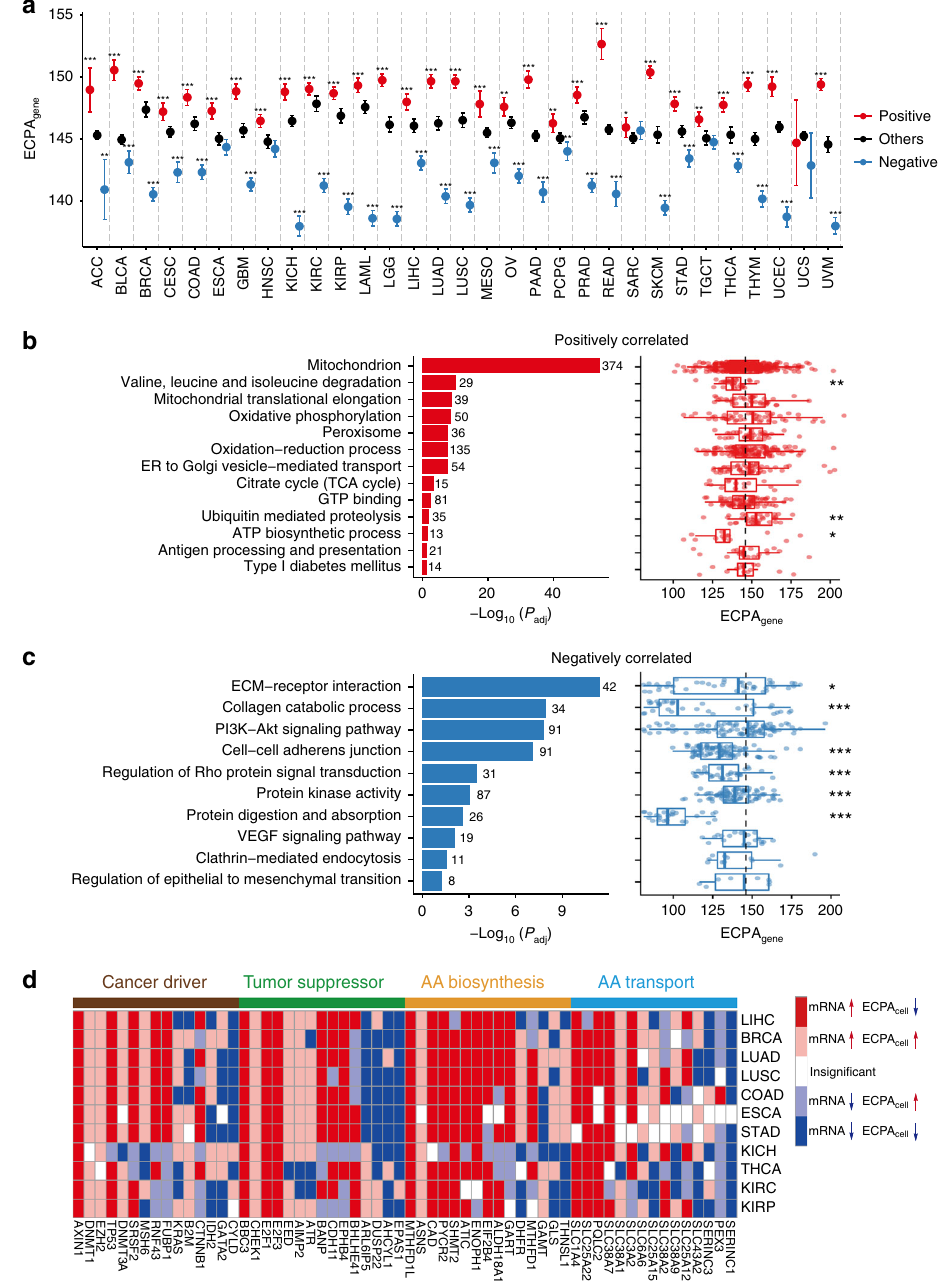
Fig. 6 Genes and pathways associated with ECPA cell across 31 TCGA cancer types. a Distribution of ECPA gene of the genes that had expression levels positively (red) or negatively (blue) correlated with ECPA cell among samples (FDR-adjusted P < 0.05) and the other genes (black) in each of the 31 cancer types with at least 50 samples. The number of positively or negatively correlated genes is presented in Supplementary Table 8. Error bars indicate 95% con fi dence intervals. Wilcoxon ’ s rank-sum tests were performed to compare the ECPA gene of positively or negatively correlated genes and that of the remaining genes (* P < 0.05; ** P < 0.01; *** P < 0.001). b Pathways over-represented in positively correlated genes and the distribution of ECPA gene of genes in each pathway (number of genes displayed beside the bar). ECPA gene of positively correlated genes in each pathway compared to genomic background (dashed line) with Wilcoxon rank-sum tests. c Pathways over-represented in negatively correlated genes and the distribution of ECPA gene of genes in each pathway (number of genes displayed beside the bar). ECPA gene of negatively correlated genes in each pathway compared to genomic background (dashed line) with Wilcoxon ’ s rank-sum tests. d Examples showing differential expression of cancer drivers, tumor suppressors and genes related to AA biosynthesis or transport between tumor and normal samples with respect to their ECPA gene in the 11 cancer types that had signi fi cantly lower ECPA cell in tumors. Up- or downregulated genes are identi fi ed with t -tests at an FDR of 0.05 and displayed in red and blue, respectively. Differential expression events that contribute to the decrease or increase of ECPA cell in tumors are displayed with dark and light color, respectively. Insigni fi cant events are shown in white. For box plots, center line, median; box limits, upper and lower quartiles; whiskers, 1.5 times the interquartile